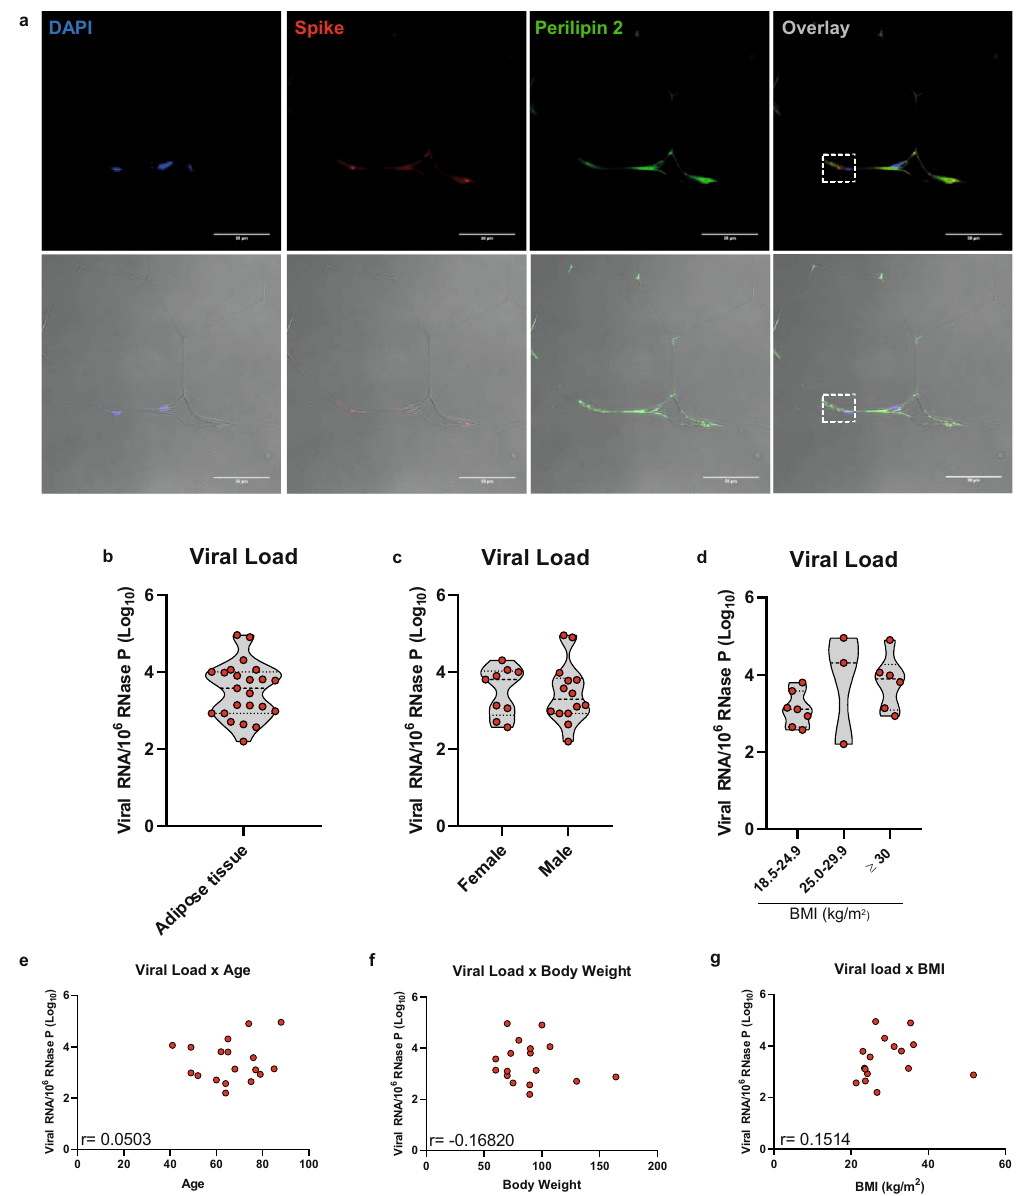
Fig.1|SARS-CoV-2infectshumanadiposetissue. Thoracicsubcutaneousadipose tissue samples of individuals who died of COVID-19. a Representative immuno- fl uorescenceimagesof6 – 8framesoftwoindividuals.DAPI,blue.SARS-CoV-2spike protein, red. Perilipin 2, green. The dashed box marks an area of an overlay with a concentration of spike labeling. The bottom panels are the overlay with the bright fi eld. Scale bar=50 µ m. b – d Copy number of the SARS-CoV-2 genome normalized by 10 6 copies of the endogenous RNase P gene as evaluated by RT-qPCR in the adipose tissue biopsies ( n =23) ( b ) and strati fi ed by sex ( n =23) ( c ),and body mass index (BMI) ( n =16) ( d ). Violin plots show median, fi rst and third quartiles of the means related to genomic copies, where each dot represents a biological